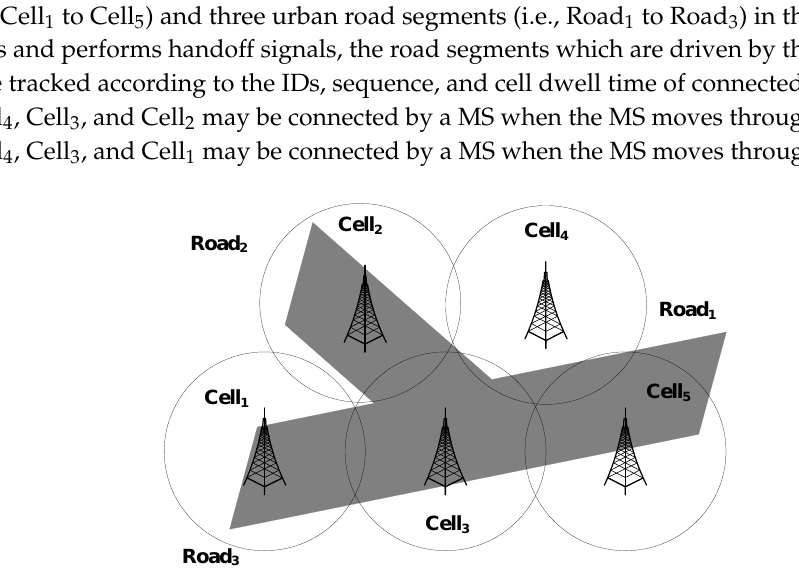
Figure 2. The case study of an urban road network and cell coverage.